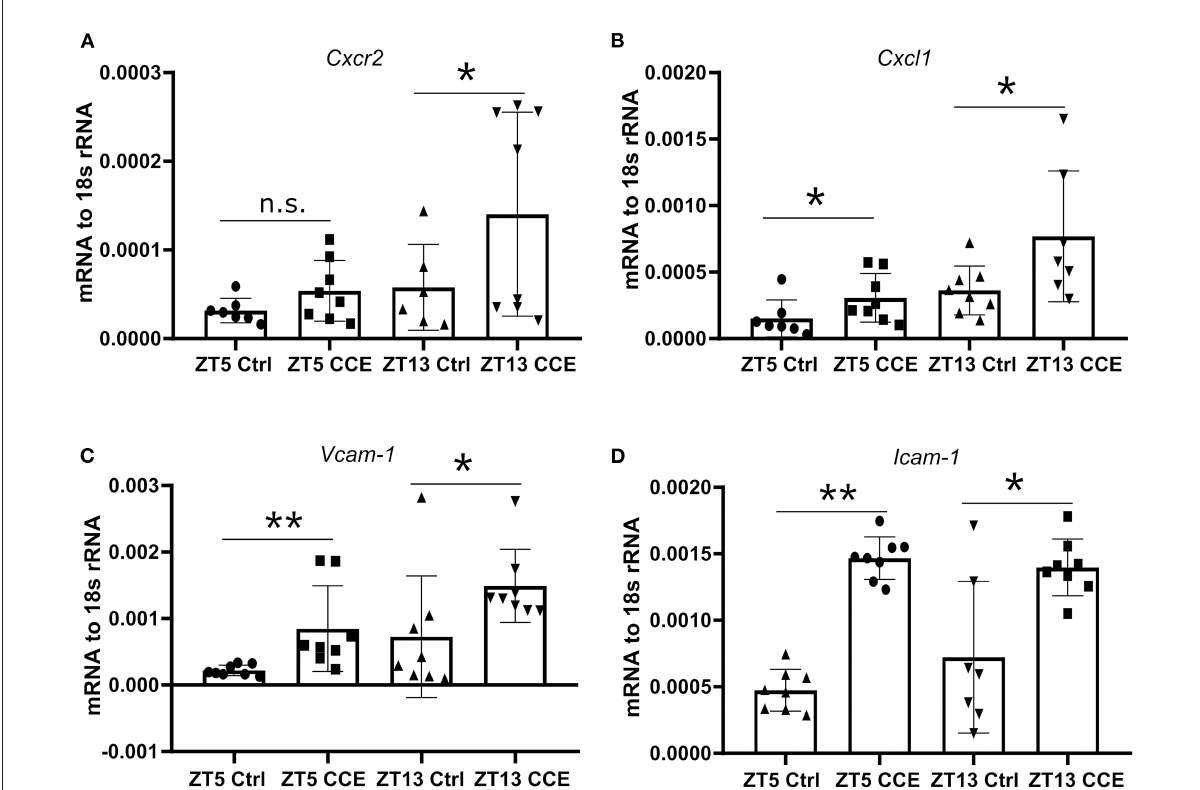
FIGURE5 Enhanced kidney neutrophil recruitment is CXCR2 dependent. The intrarenal mRNA expression level of Cxcr2 ( A , n = 6–8 mice/group), Cxcl1 ( B , n = 7–8 mice/group), Vcam-1 ( C , n = 7–8 mice/group), and Icam-1 ( D , n = 7–8 mice/group) at ZT5 and ZT13 before and post-CC injection. Data are means ± SD . Icam-1 , intercellular adhesion molecule 1; Vcam-1 , vascular cell adhesion molecule 1; Cxcr2 , CXC chemokine receptor 2; Cxcl1 , CXC motif chemokine ligand 1. Unpaired Student’s t -test, * P < 0.05, ** P <